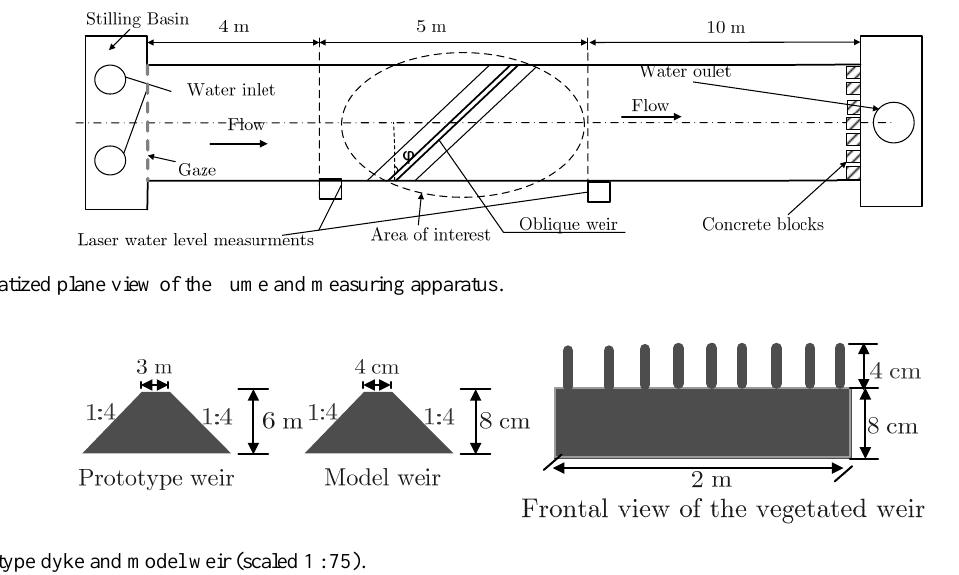
Fig. 10. Prototype dyke and model weir (scaled